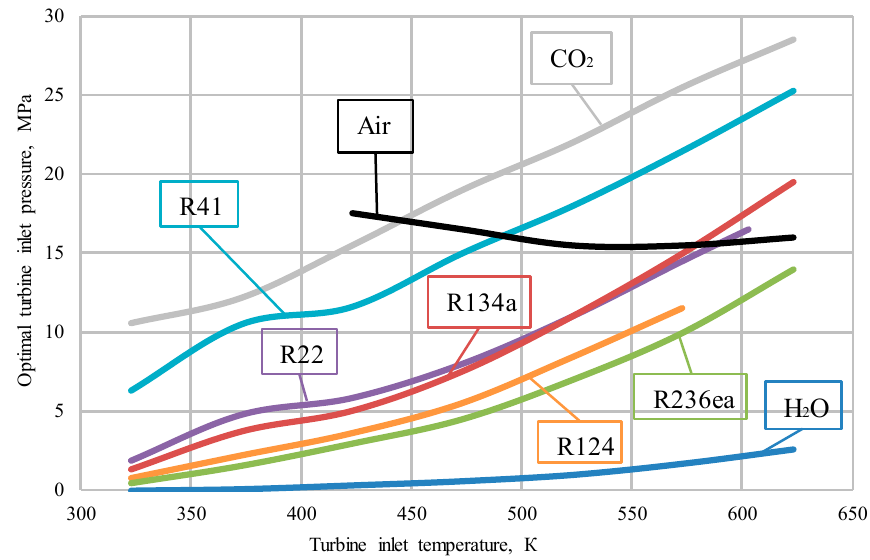
Figure 15. Optimal initial pressures for cycles with regenerator at different initial temperatures.